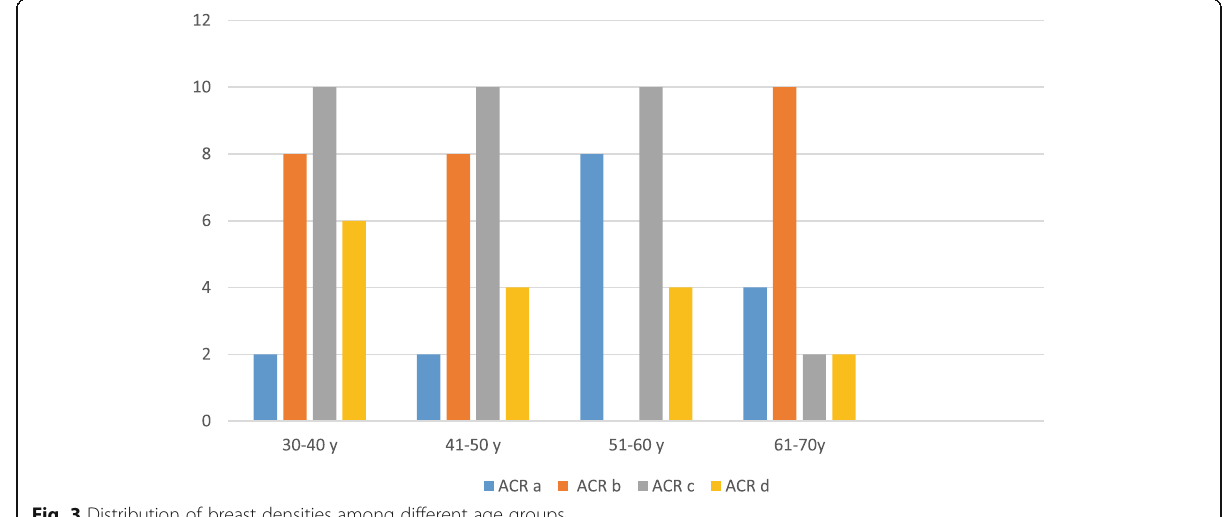
Fig. 3 Distribution of breast densities among different age